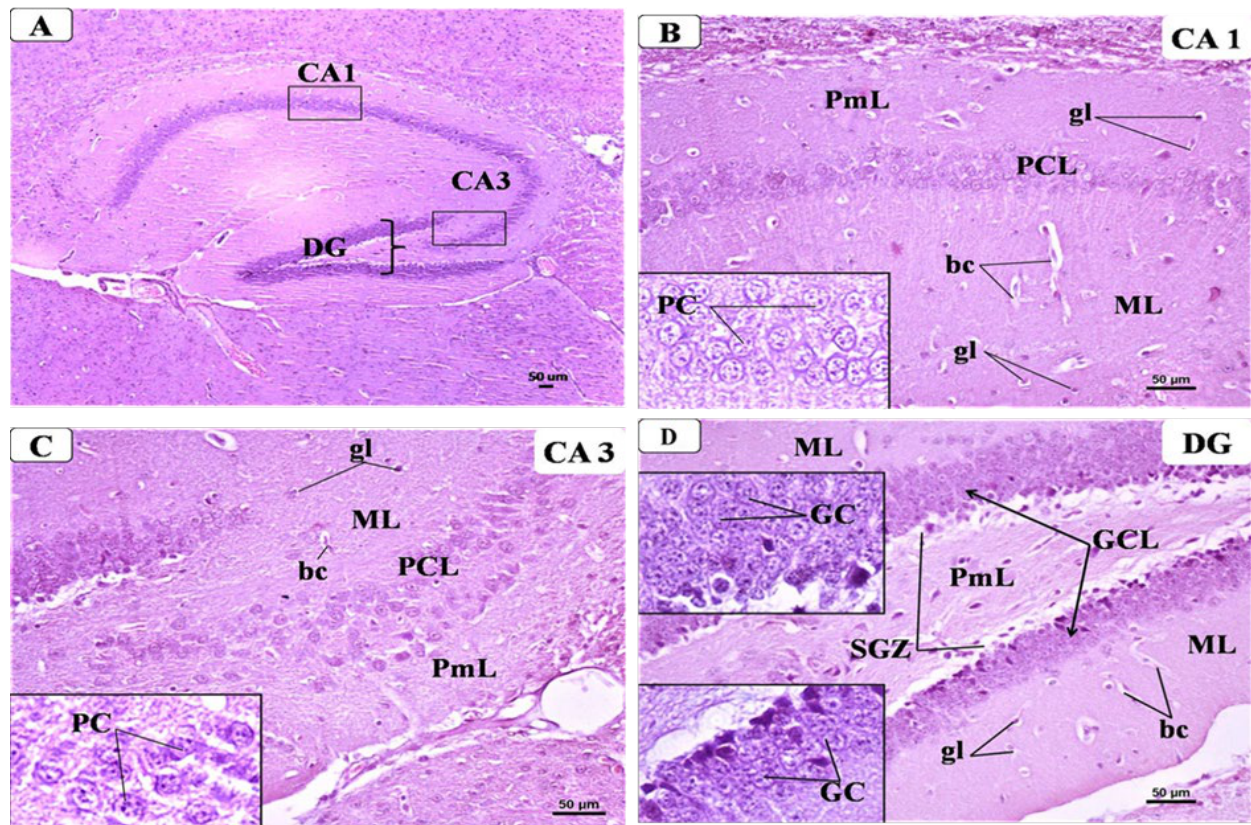
Figure 7. Representative photomicrographs of H&E-stained brain sections showing the hippocampus: from control group: ( A ) C-shaped Cornu Ammonis (CA) with its CA1, CA3, and dentate gyrus (DG). (H&E × 40). ( B ) CA1 was formed of three layers: outer molecular layer (ML), middle pyramidal cell layer (PCL), and inner polymorphic layers (PmL). PCL was formed of well-organized compact layers of small pyramidal cells (PC) containing large vesicular nuclei and pale basophilic cytoplasm (Inset). Both ML and PmL contained some glial cells (gl) with small dark nuclei and perinuclear halos and few blood capillaries (bc) inside the pinkish neuropil matrix. (H&E × 200, inset × 400). ( C ) CA3 was formed of three layers: the molecular layer (ML), pyramidal cell layer (PCL), and polymorphic layers (PmL). PCL was formed of less packed large pyramidal cells with large vesicular nuclei with prominent nucleoli and pale basophilic cytoplasm (inset). Both ML and PmL contained some glial cells (gl) with small dark nuclei and perinuclear halos and few blood capillaries (bc) inside the pinkish neuropil matrix. (H&E × 200, inset × 400). ( D ) DG of control group showing three layers: molecular layer (ML), granular layer (GCL), and polymorphic (PmL) of both upper and lower limbs. Insets displayed GCL, which is the main layer that contained densely packed granular cells (GC) with dark nuclei. Both ML and PmL contained some glial cells (gl) and blood capillaries (bc). A sub-granular zone (SGZ) was seen below GL containing small neurons with oval deeply stained